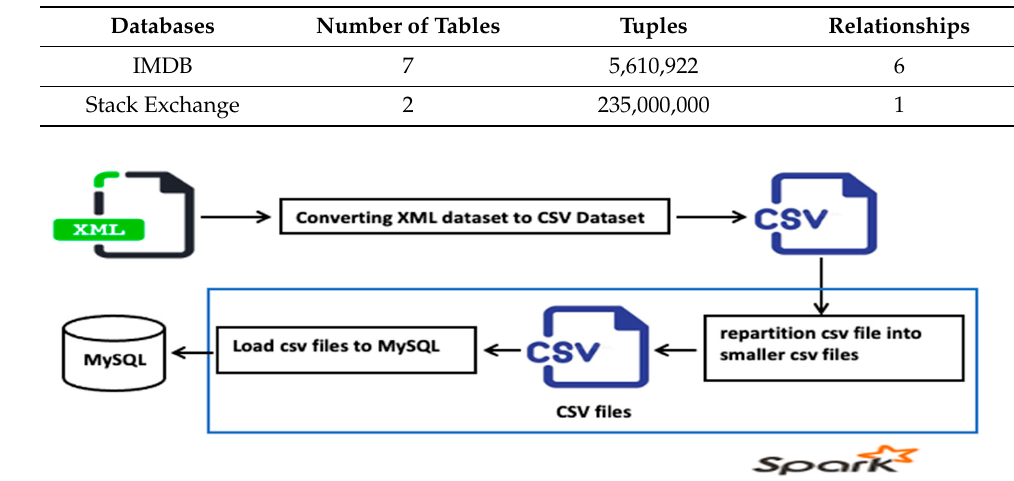
Figure 6. The pipeline for preprocessing of the Stack Exchange